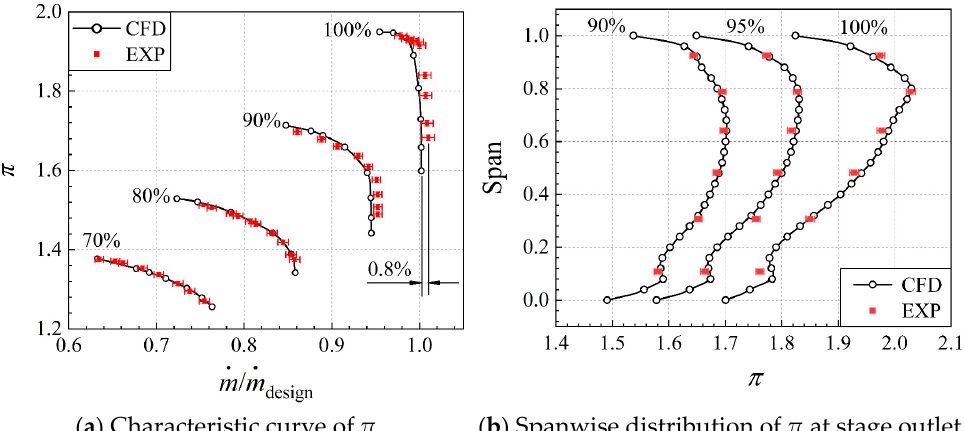
Figure 6. Comparison between the numerical simulation and experimental results of the baseline fan